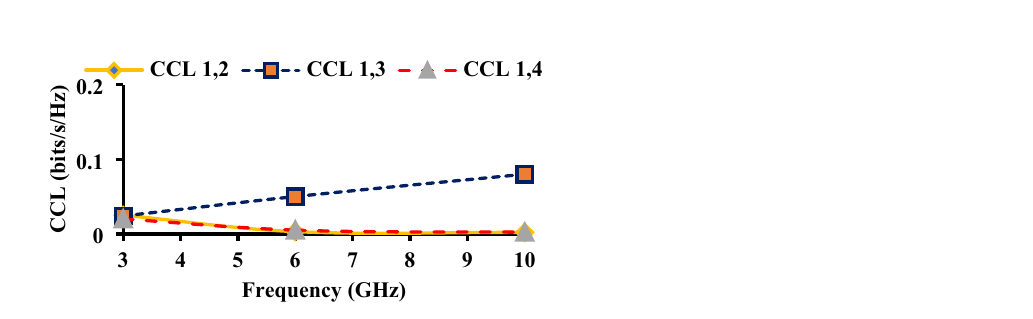
Figure 19. TARC of the proposed antenna.